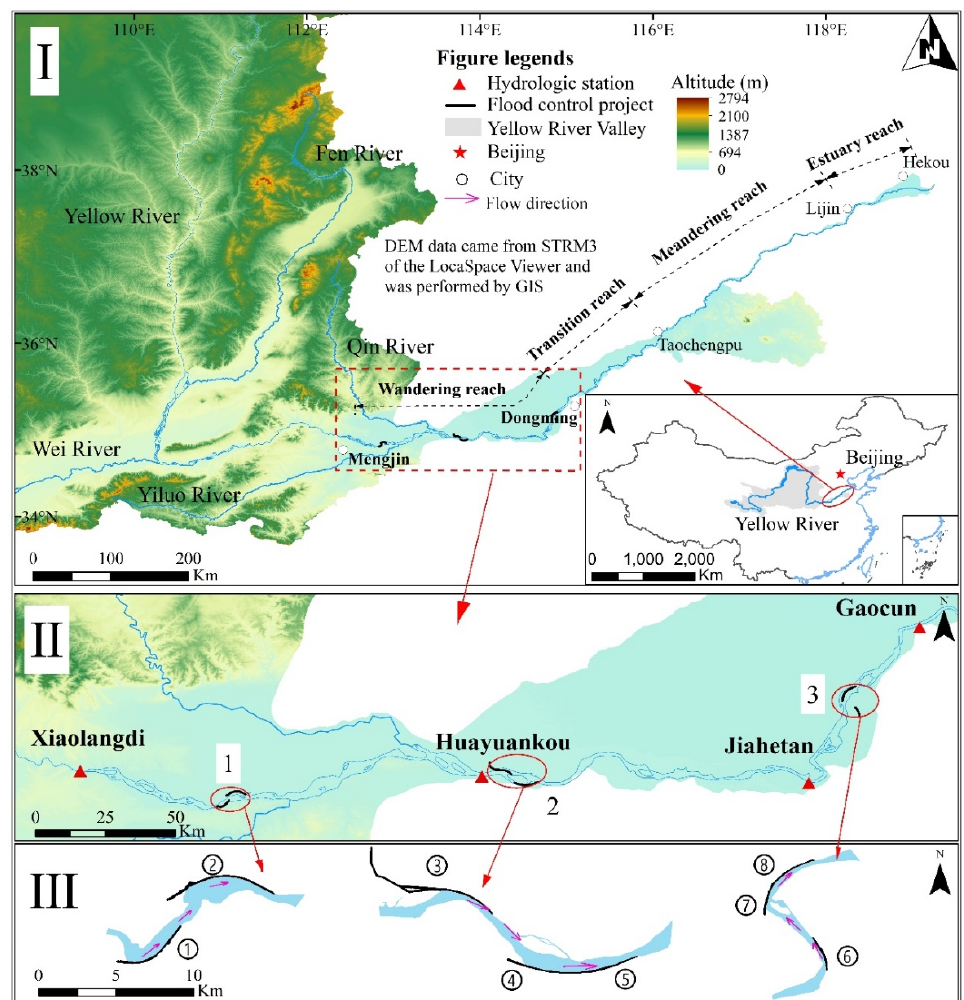
Figure 1. Selection of wandering reach in the lower Yellow River with a stable river regime: I. The lower Yellow River, II. The wandering section in the lower Yellow River, here, 1 refers to Huayuanzhen-Peiyu reach, 2 refers to Huayuankou-Laitongzhai reach, 3 refers to Youfangzhai-